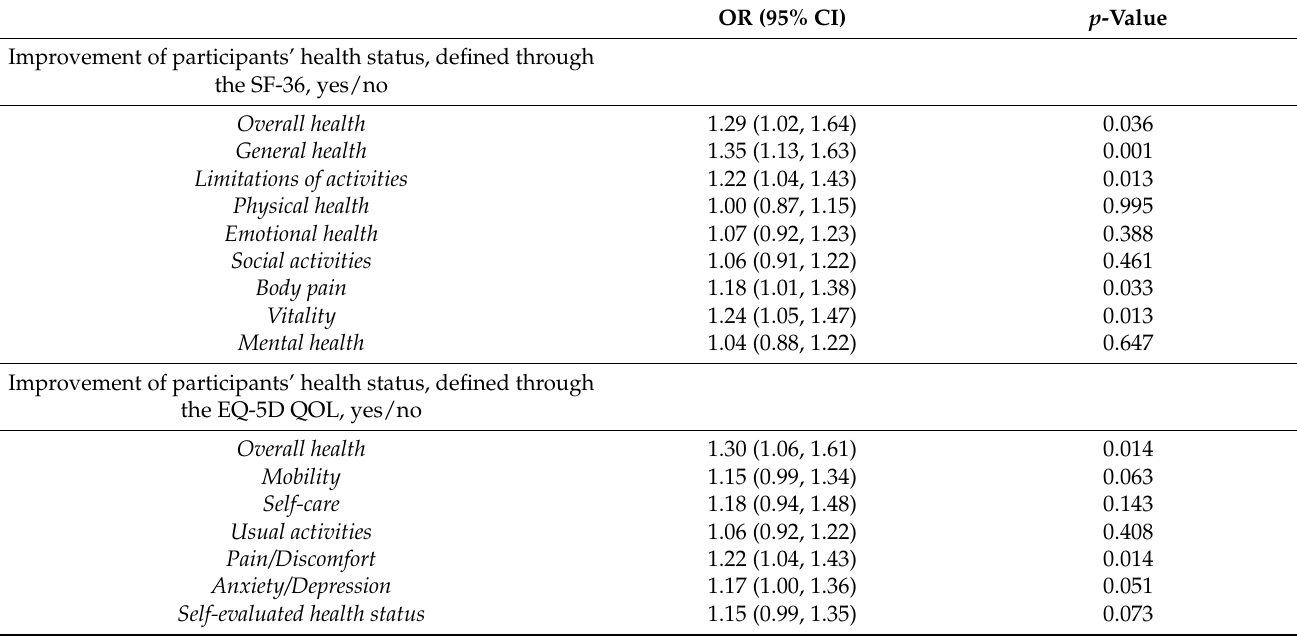
Table 3. Multi-adjusted logistic regression with the independent variable as the change in food insecurity score (improvement of food security) * between baseline and the 12-month follow-up and the dependent variable being the respective quality of life parameters. OR (95% CI) p